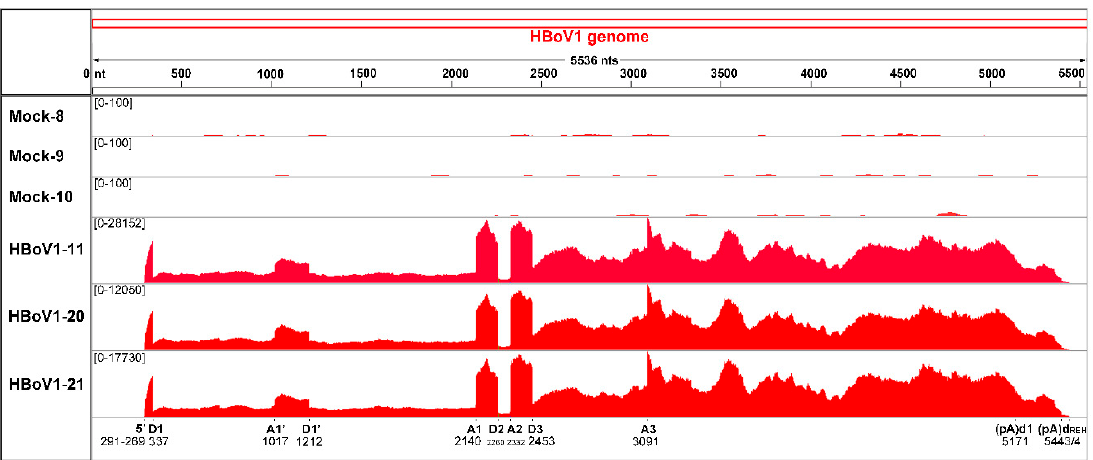
Figure 3. Analysis of alternative splicing of HBoV1 pre-mRNA. The mRNA-seq reads of three HBoV1-infected (HBoV1-11, 20, and 21) and three mock-infected (Mock-8, 9, and 10) RNA samples are mapped to HBoV1 genome. Histograms show the frequency of mRNA reads across the coverage of the HBoV1 genome. The junction events were identified only when at least a single read splits across two exons. The identified splicing junctions are labeled at the bottom with nucleotide numbers shown. The range of reads numbers are shown in each sample. The reads number of all identified splicing events including novel identified splicing and the donor and acceptor sites are shown in Table 2. Table 2. Detected splicing events in HBoV1 infected HAE cells.